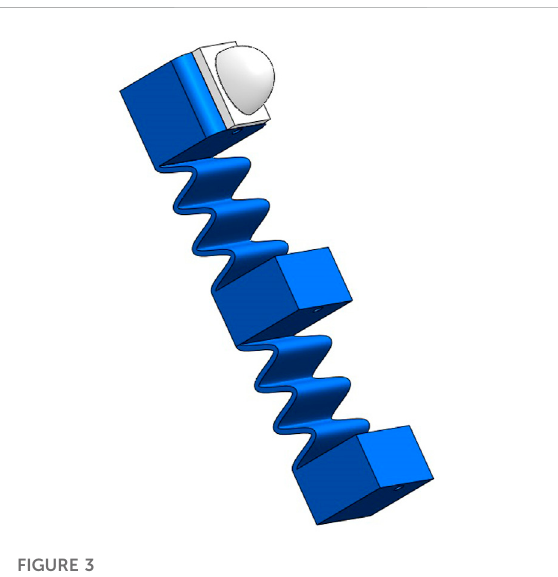
FIGURE 3 Design of the sample fi nger, equipped with the soft, silicone- based, fi